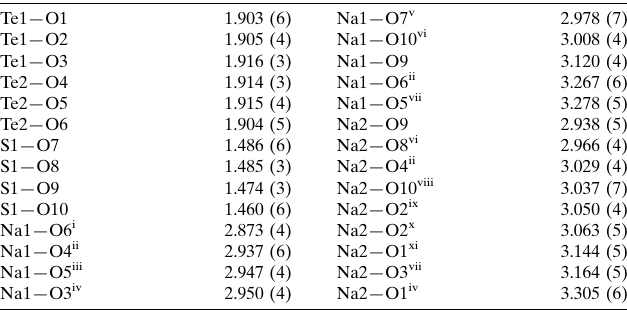
Selected bond lengths (A˚ ).